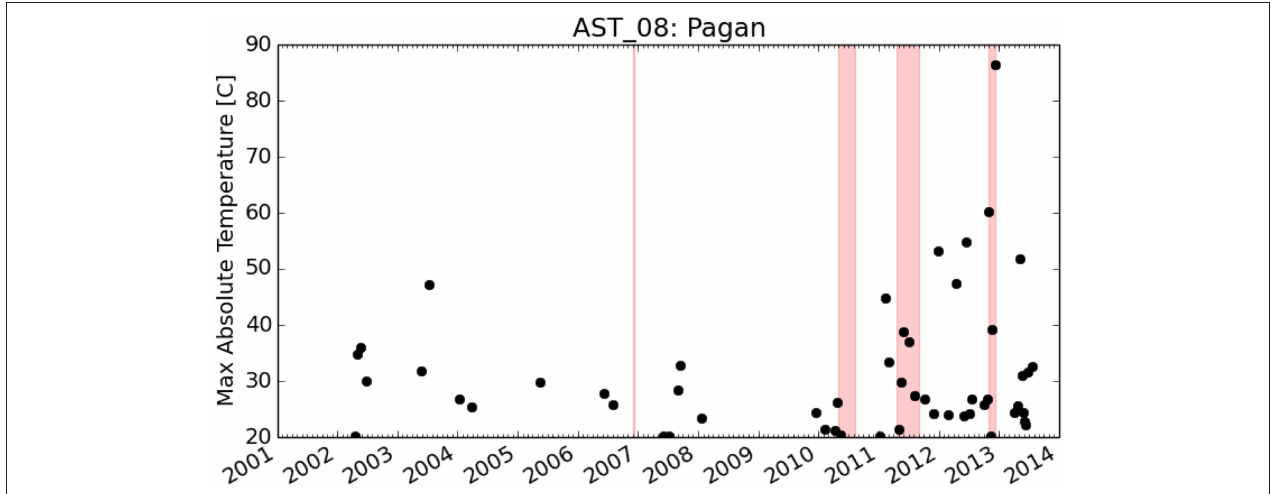
FIGURE 6 | ASTER Product 8: Surface Kinetic Temperature night-time measurements of the maximum single pixel in a 3 × 3 pixel box centered on the central vent of Mt. Pagan. Note that values represent an average temperature for a ground surface area of 8,100 square meters. Red vertical spans indicate eruptive episodes documented in the GVP database ( Global Volcanism Program, 2013). No clear pre-eruptive trends in temperature are visible, although anomalously high temperatures are measured during eruptive episodes.